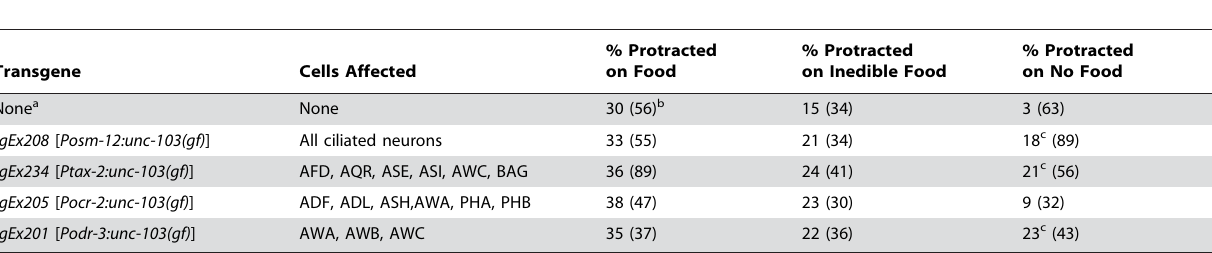
Table 2. Chemosensory neurons suppress unc-103(0) -seizures in the absence of food stimulus.